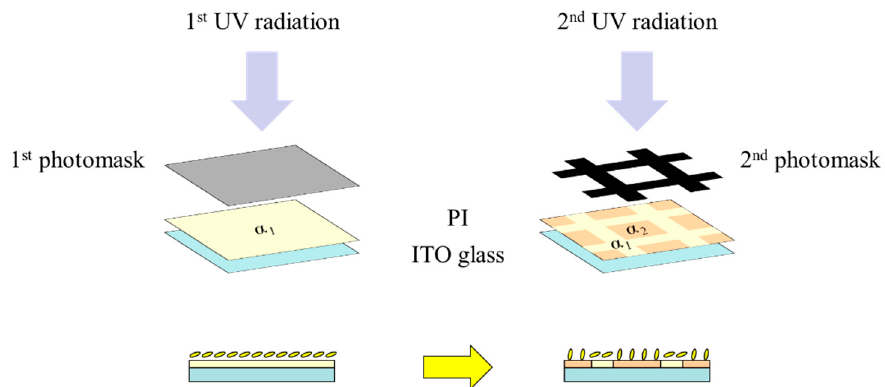
Figure 10. The proposed fabrication procedure of an LCoS with FFE-opposing features.